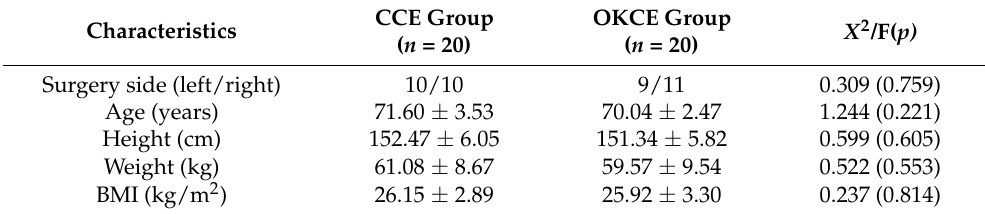
Table 3. Demographic characteristics ( n =